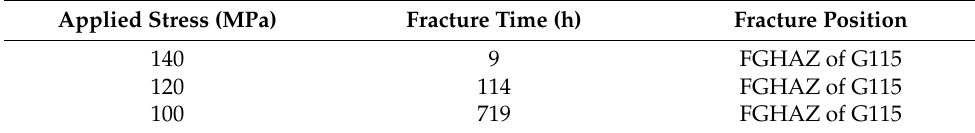
Figure 1. Welded joint: ( a ) Macro morphology of weld; ( b ) Weld cross section The axis of the creep specimen is perpendicular to the welding direction. The gauge length is 25 mm and the diameter is 5 mm. The weld is located in the middle of the gauge length section, and the axis of the specimen is located in the middle of the joint wall thickness. The creep test was carried out at 675 ◦ C with 140 MPa, 120 MPa and 100 MPa stress respectively. The creep life and fracture position are shown in Table 2. Table 2. G 115/Sanicro25 joint creep rupture test results.